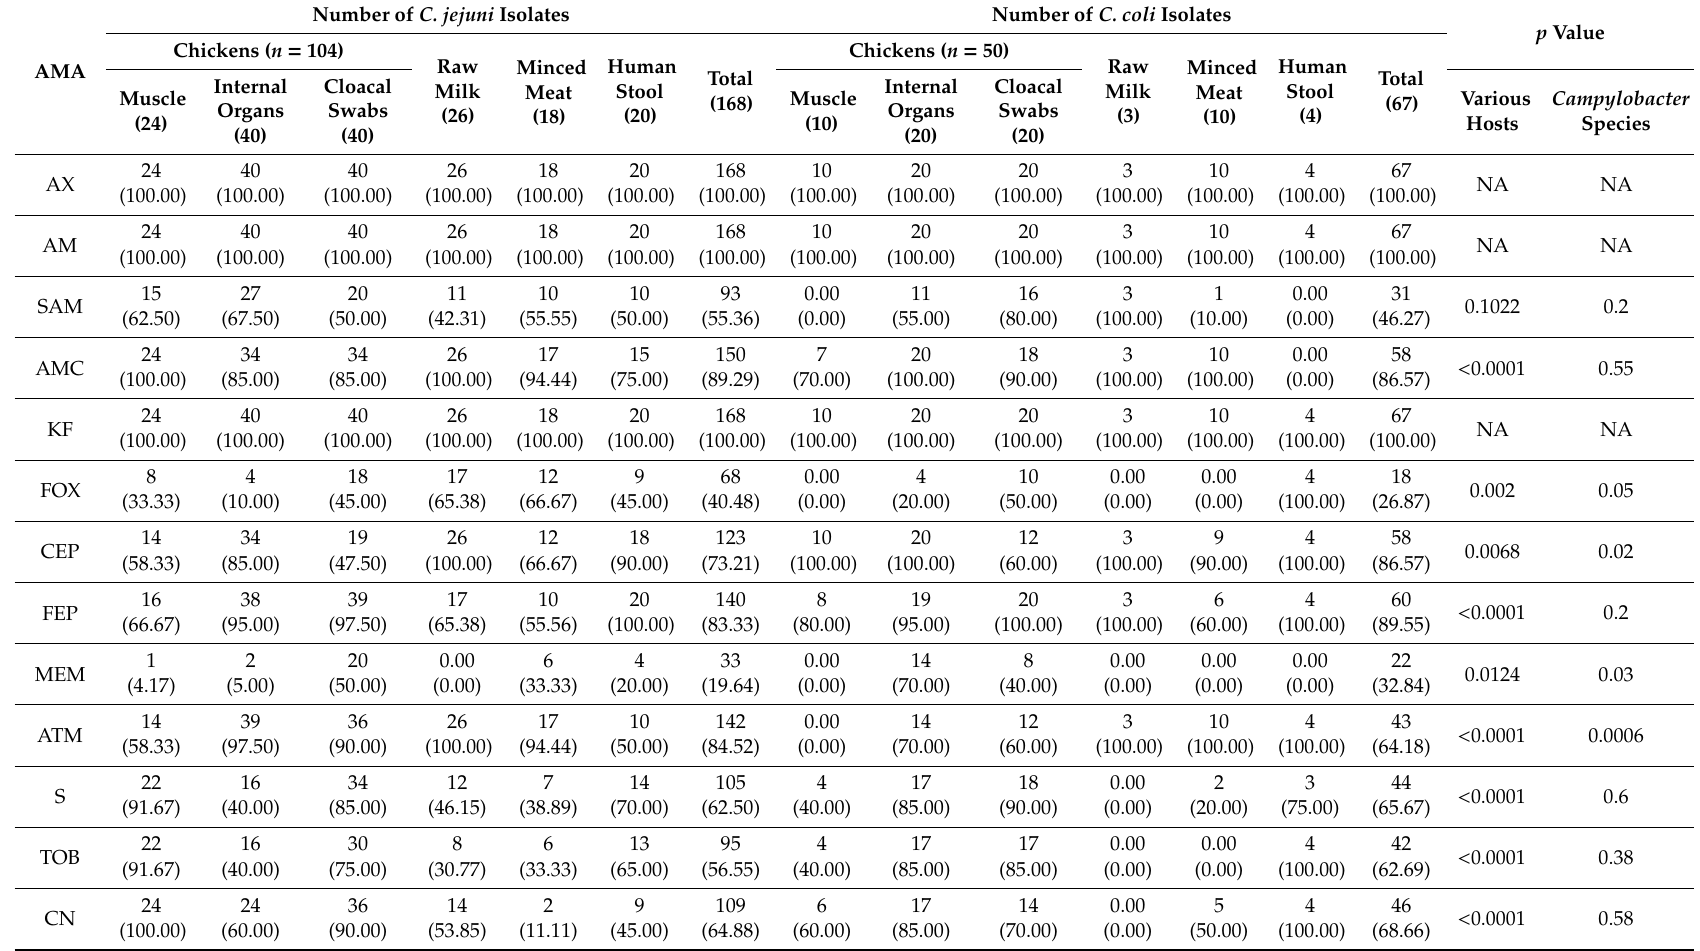
Table 2. Antimicrobial resistance pattern of Campylobacter species isolated from di ff erent